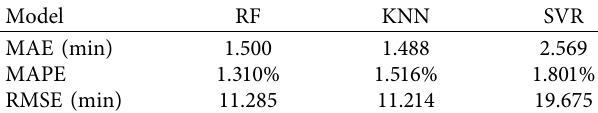
Table 7: Evaluation index calculation table.